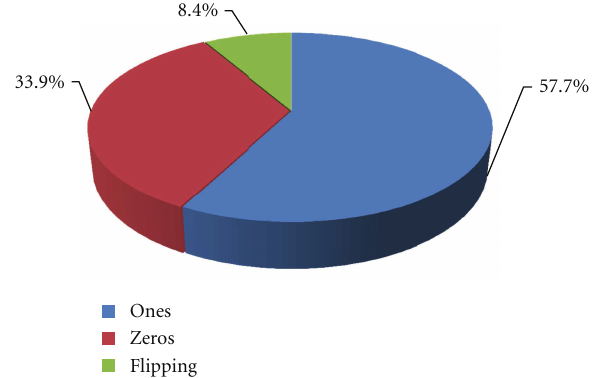
Figure 3: Mean occurrences of constant ones and zeros as well as flipping bits of Table 2.